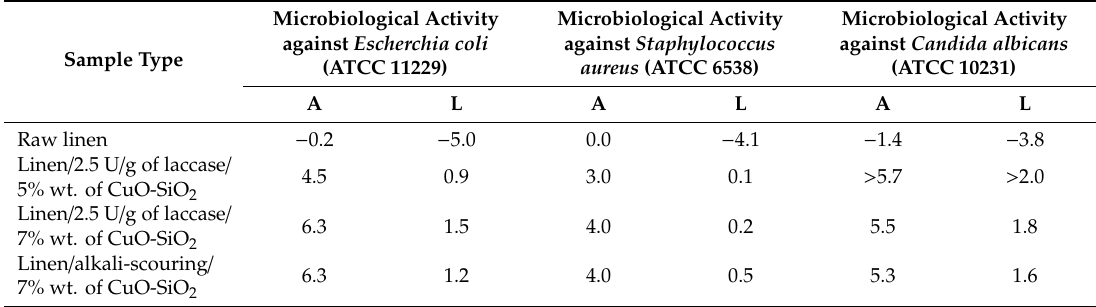
Table 2. Microbiological activity of linen fabric samples modified by alkaline or enzymatic treatment and dip-coating with CuO-SiO 2